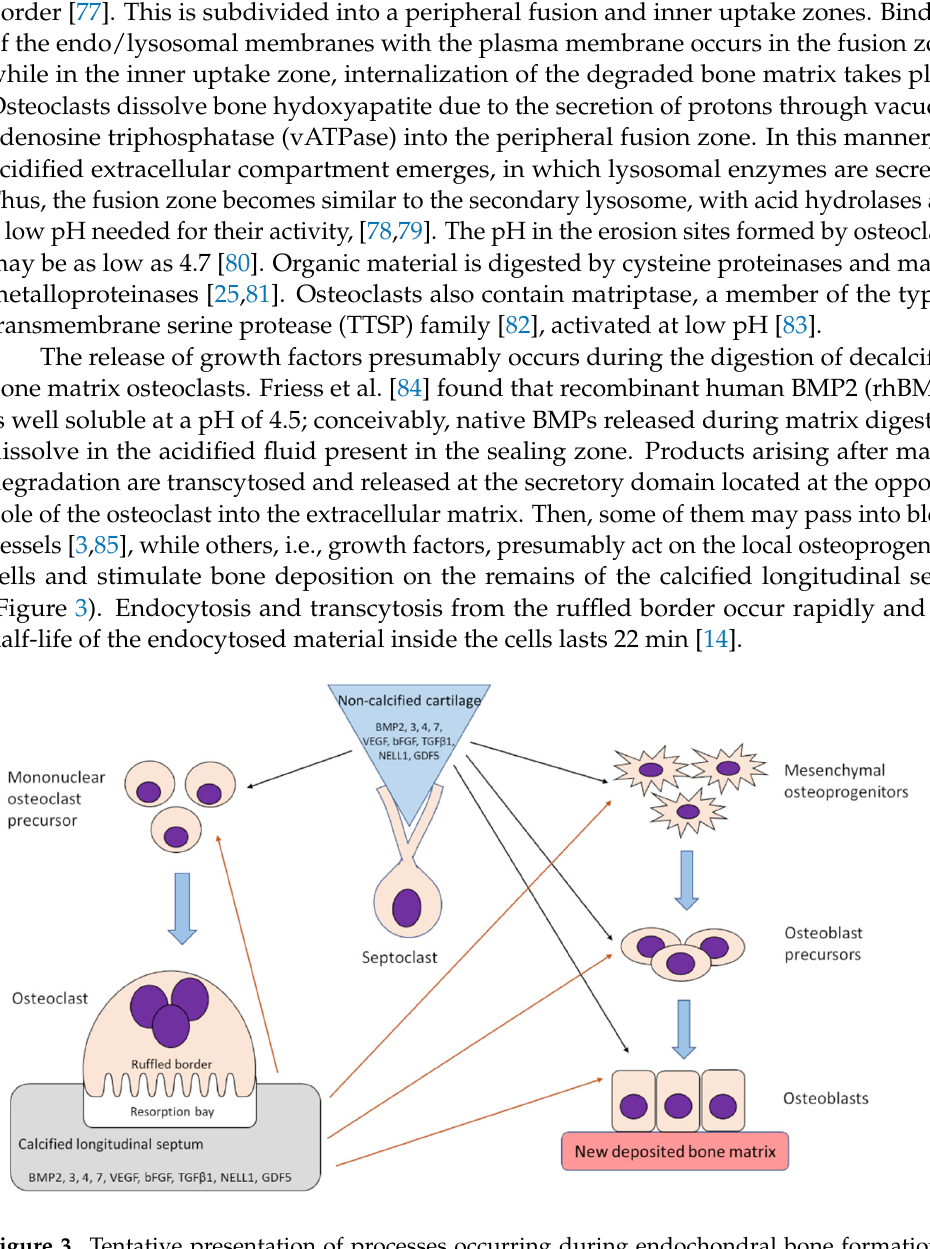
teine residues and form homodimers where two BMP molecules are joined by a disul- phide bridge through a seventh cysteine residue [86]. A similar cystine-knot is present in miniproteins and is considered to be responsible for their exceptional stability towards thermic or proteolytic degradation [87,88]. Thus, it is conceivable that the presence of the cystine knot protects BMPs during transport from the sealing zone to the extracellular space. It may also be significant that BMPs and GDFs bind to heparin and heparin/heparan sulphate [89]. The heparan sulphate (HS) chain of HSPGs (heparan sulphate proteogly- cans) is a linear polysaccharide that supplies docking sites for the HS-binding ligands via electrostatic interactions [90]. Thus, growth factors released by osteoclasts from the bone matrix could bind to heparan sulphate in the ruffled membrane of the inner uptake zone and be transported by endocytosis to the secretory domain. Interestingly, Kim et al. [91] found that upon incubation of rhBMP2 and rhBMP7 with Chinese hamster ovary (CHO) cells, both agents bonded to the cell surface HSPGs, but only rhBMP2 was actively inter- nalized. Native BMPs may behave differently than recombinant forms, and osteoclasts obviously differ from CHO cells; nevertheless, the mechanism of growth factor transport by osteoclasts in view of the results of Kim et al. [91] may be more complex than suggested above. 11. Formation of Osteoclasts Resorbing Calcified Cartilage Is Stimulated by Factors Released from Non-Calcified Cartilage by Septoclasts While osteoclasts may release and transport growth factors deposited in a calcified cartilage matrix, the stimulus for their formation may originate from the non-calcified ma- trix accompanying the former. Non-calcified cartilage in the zone of provisional calcifica- tion is resorbed by septoclasts, the cells accompanying the capillary sprouts growing from metaphysis and characterized by a high content of cathepsin B [92,93] and selective